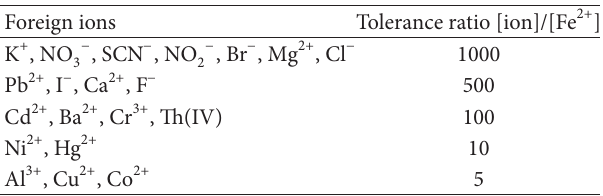
T 2: e effect of different ions on the determination of